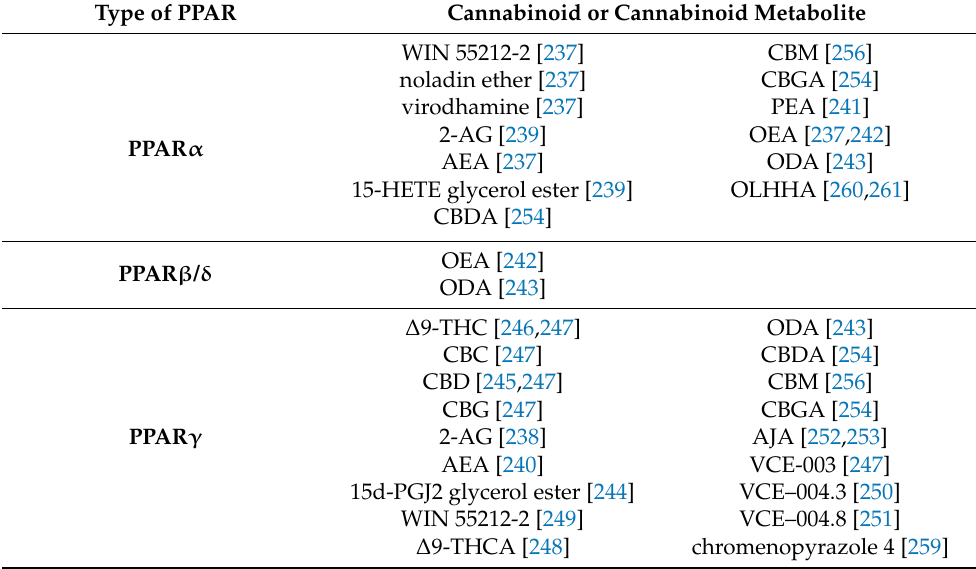
Table 3. PPAR activation by cannabinoids and cannabinoid